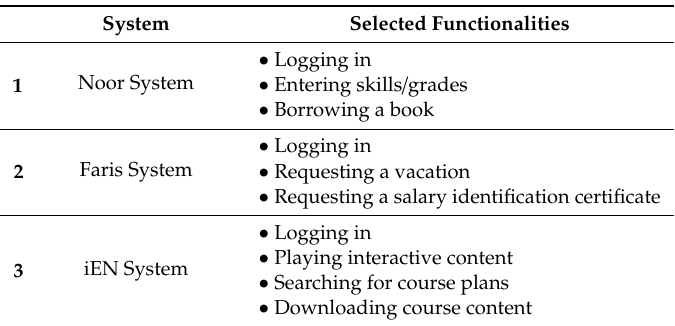
Table 1. The final selected functionalities for each